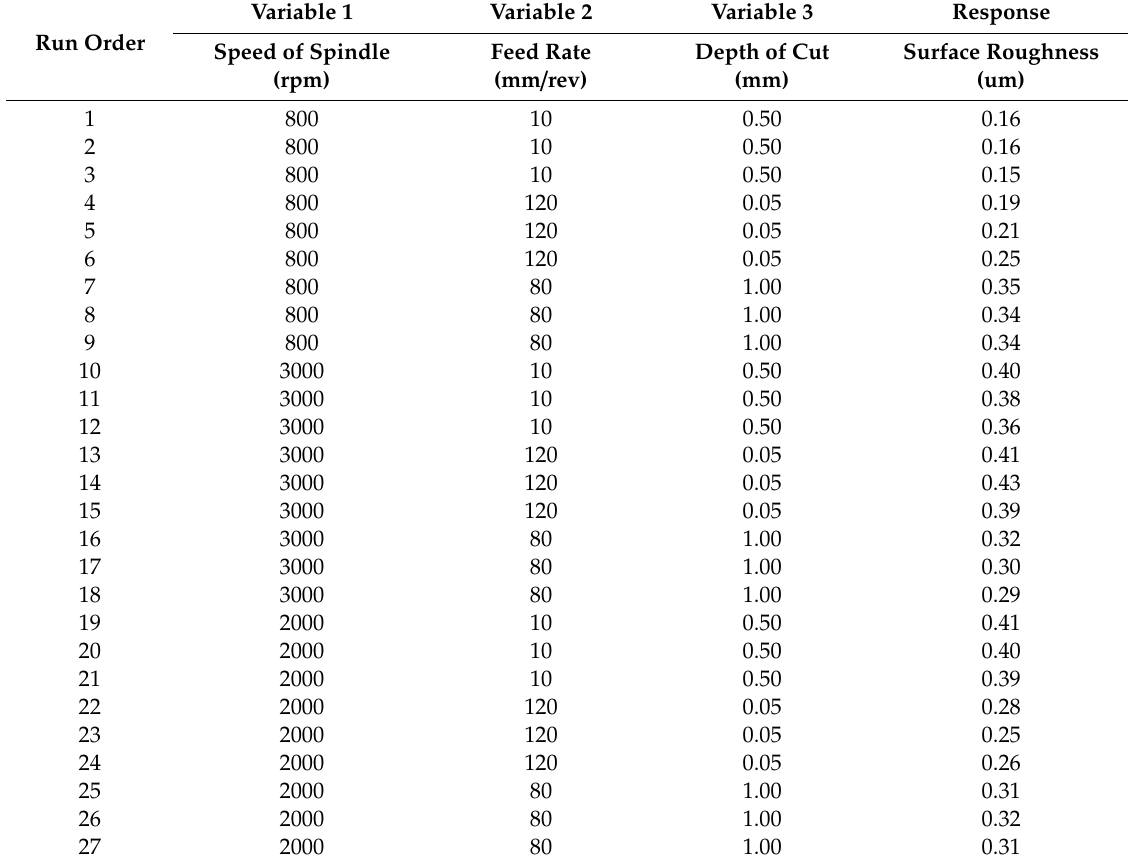
Table A2. Experiments and their respective response (surface